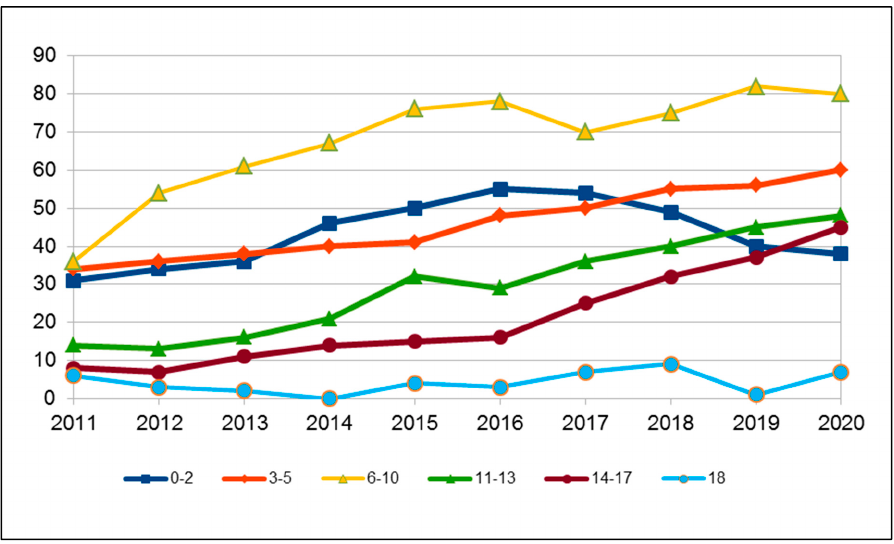
Figure 5. Q code user distribution by age range.